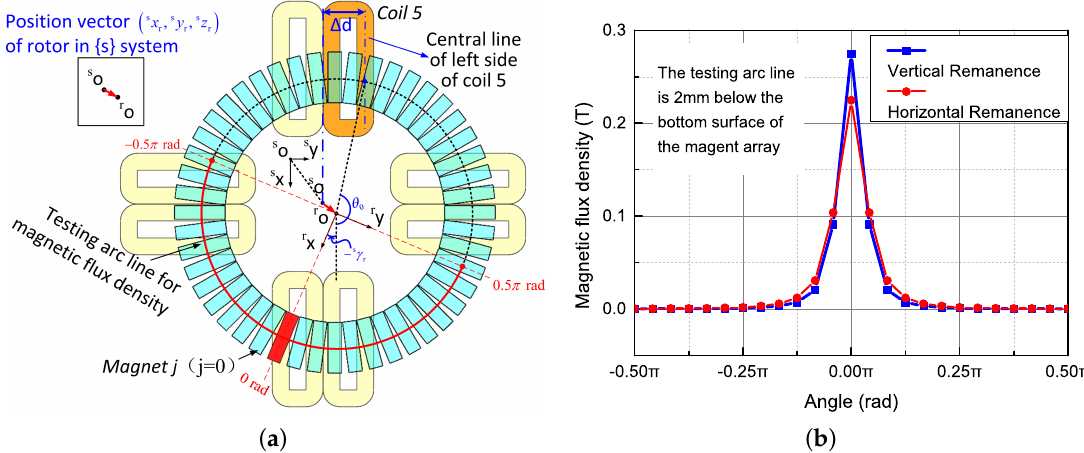
Figure 2. ( a ) Diagram of the actuator to analyze the relative angle θ e of Coil 5 in the rotor coordinate system. ( b ) Intensity of magnetic flux density along the testing arc line from Magnet 0 in ( a ) .